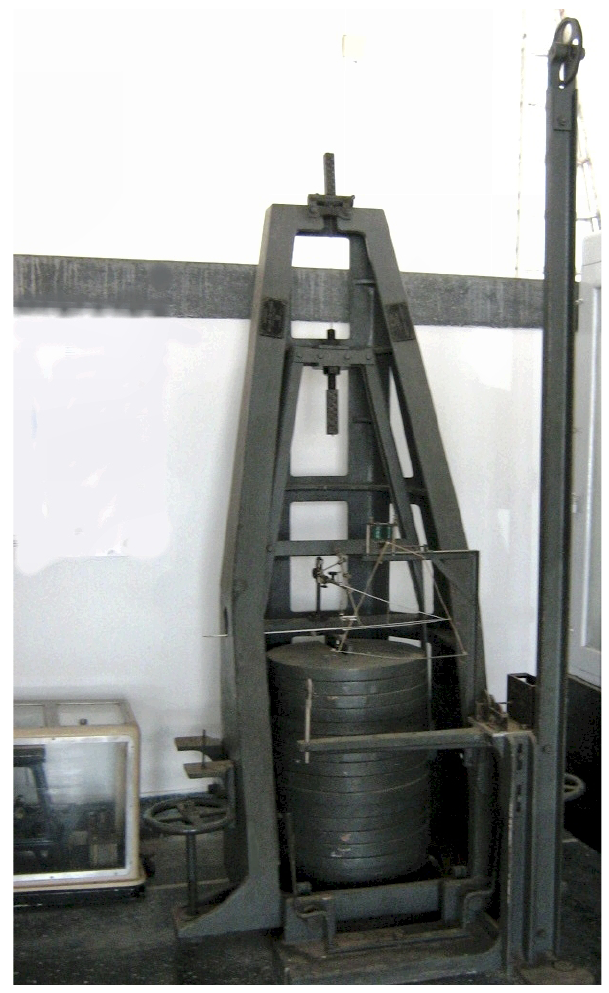
Figure 5. The first seismograph installed in Morocco, a Mainka, at Averroes Observatory in 1934. Courtesy of T. E. Cherkaoui.